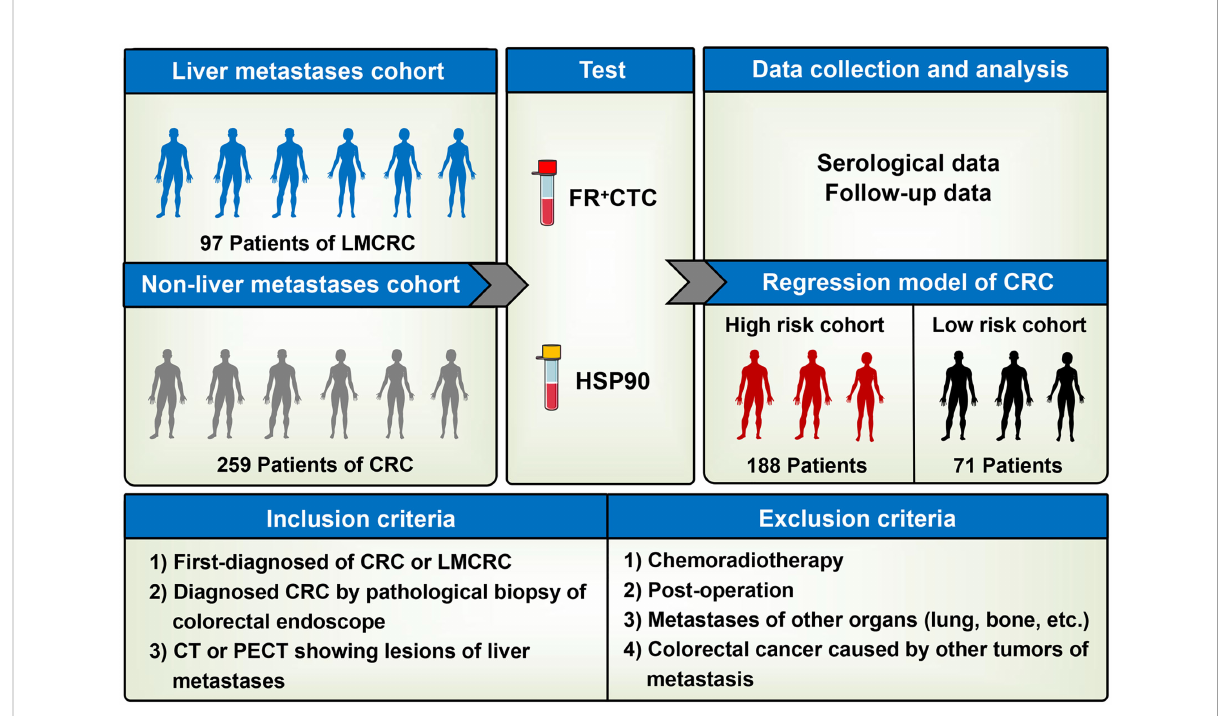
FIGURE 1 Flow chart of the study: The cohort in this study consisted of colorectal cancer patients with and without liver